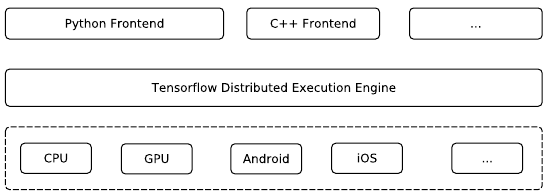
Figure 5. Tensorflow